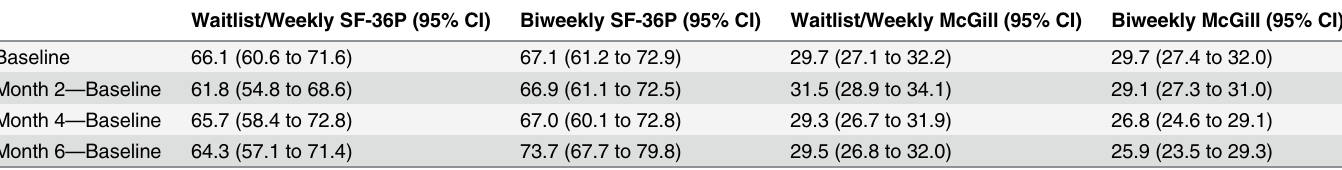
Table 2. Mean and empirical 95% confidence limits estimated for both SF-36P and McGill from 5000 simulations of the fitted GEE models. Waitlist/Weekly SF-36P (95% CI) Biweekly SF-36P (95% CI) Waitlist/Weekly McGill (95% CI) Biweekly McGill (95% CI)